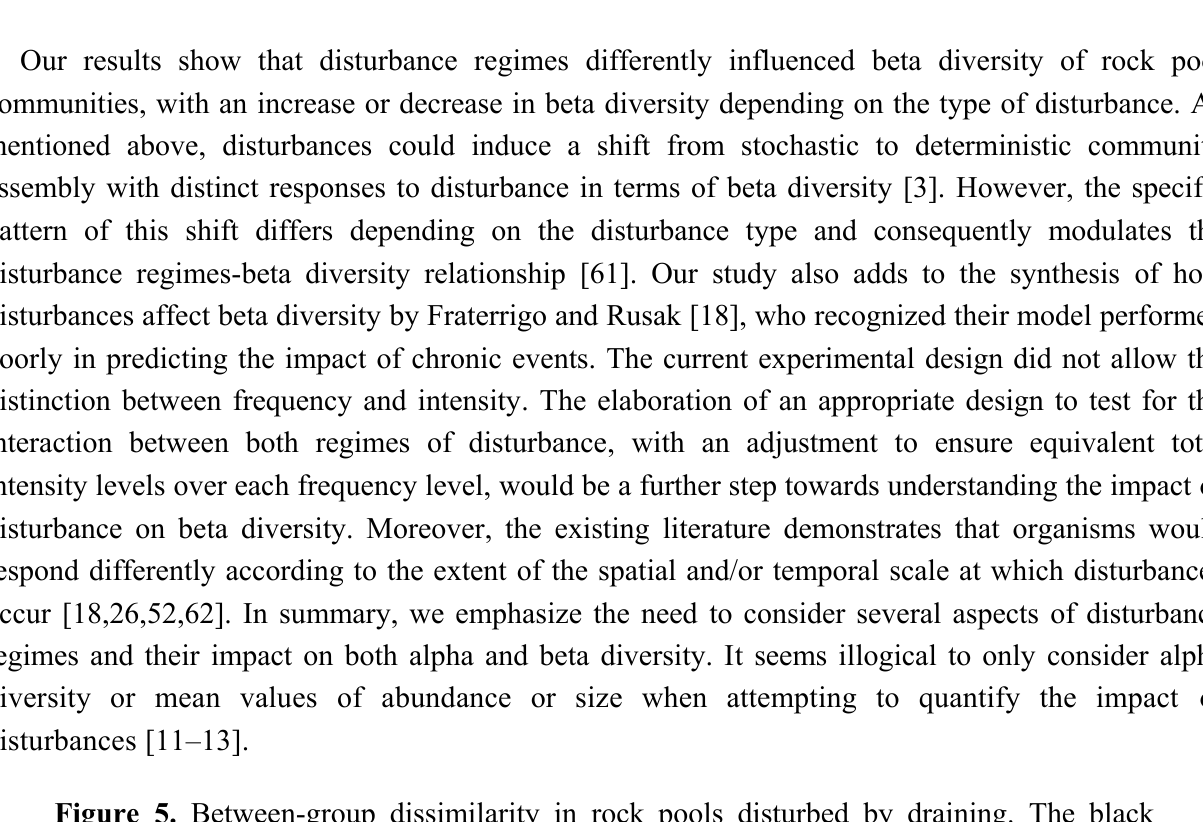
Figure 5. Between-group dissimilarity in rock pools disturbed by draining. The black vertical line represents the beginning of the disturbances. High = draining every diurnal low tide; Low = draining six times during the period; Reference = no